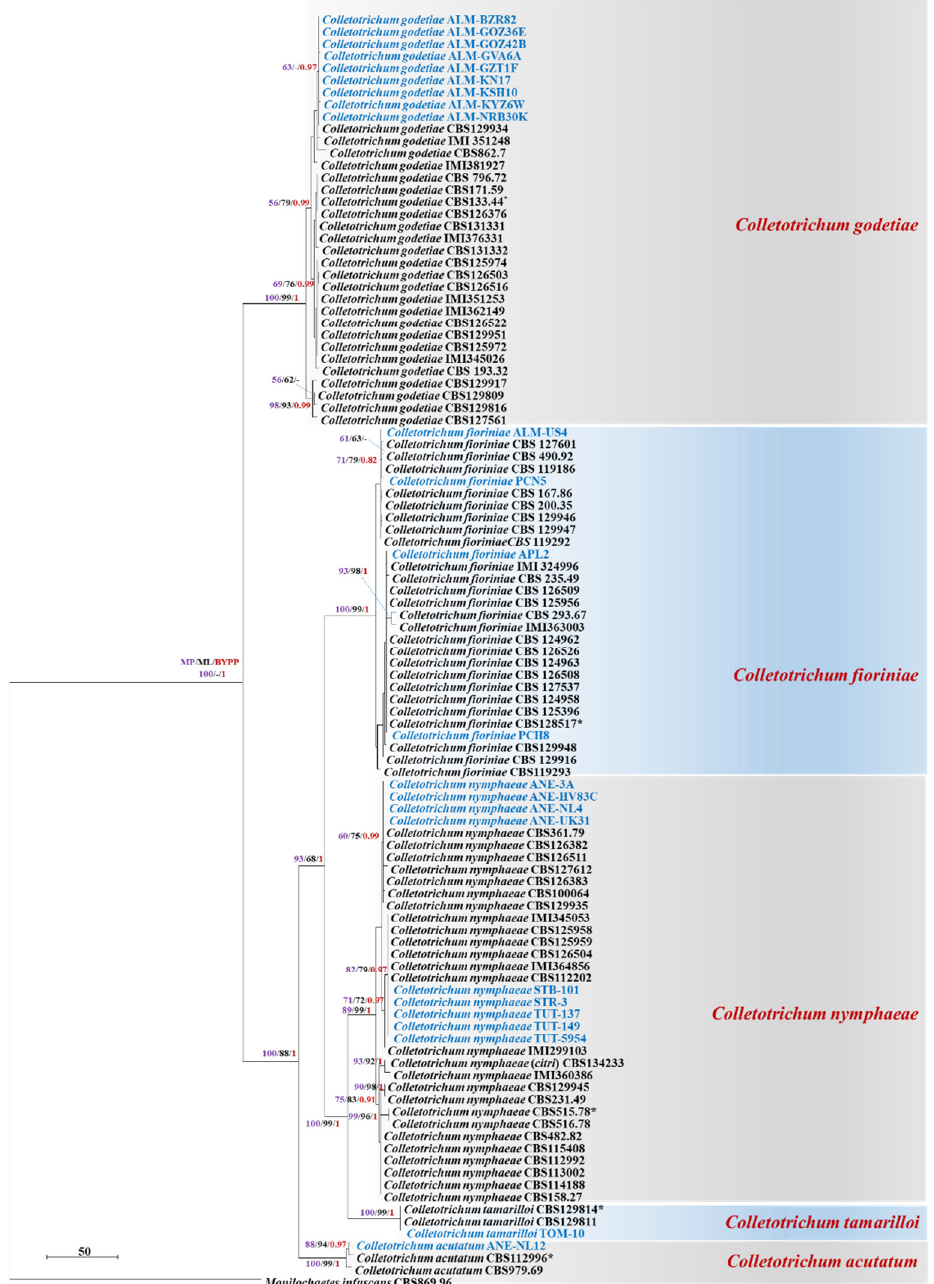
Figure 2. First of 205 equally most parsimonious trees obtained from a heuristic search of the combined ITS, act , chs1 , gapdh , his3 and tub2 sequence alignment of the representative Colletotrichum isolates belonging to the C . godetiae , C . nymphaeae , C. tamarilloi , C. fioriniae and C . acutatum clades. The MP and ML bootstrap support values (>50%) and Bayesian posterior probabilities (>0.90) are displayed at the nodes (ML/MP/PP). The tree was rooted to Monilochaetes infuscans (CBS 869.96). The bar indicates 50 changes. The isolates from this study are highlighted in blue. (* = Type strain).